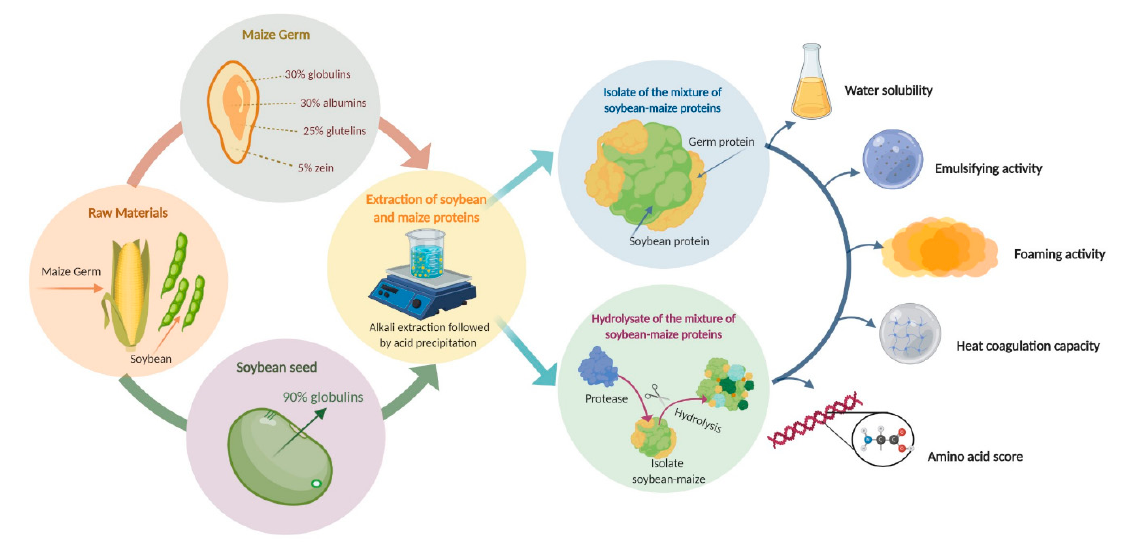
Figure 1. Process diagram to analyze the isolates and hydrolysates of soybean and soybean-maize.